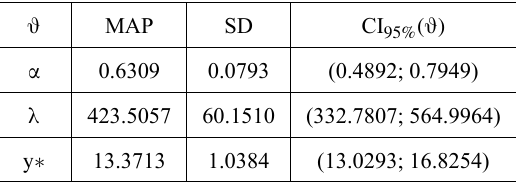
MAPs, Standard deviations and 95% credible intervals for α , λ and y ∗ related to agricultural machine’s revision